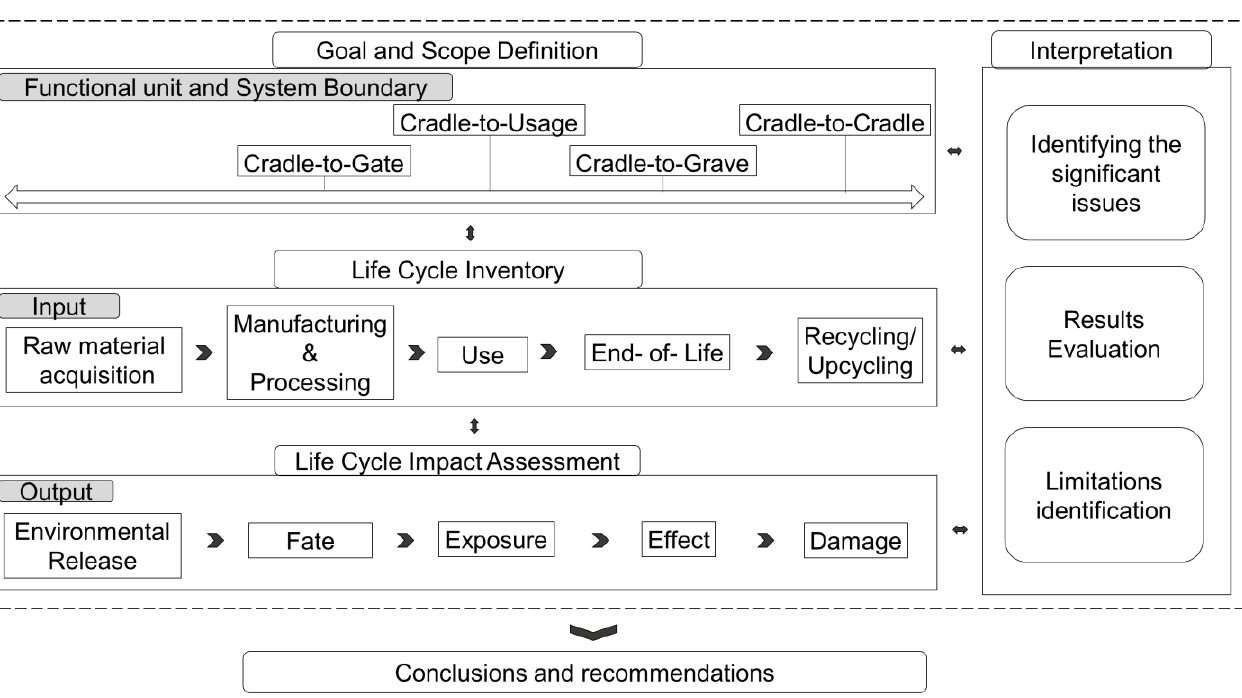
Figure 5. Overview of the four phases in LCA assessment.